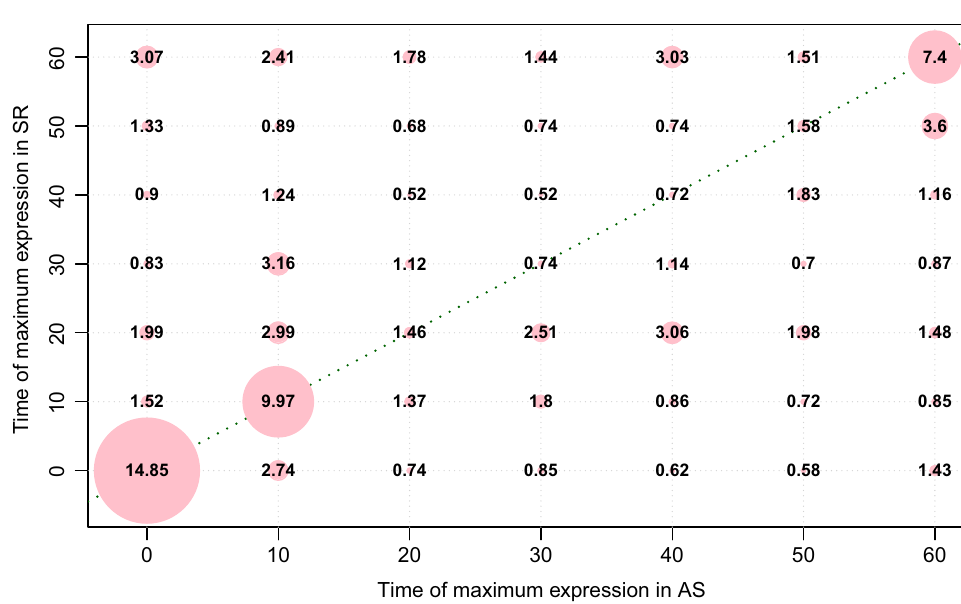
Figure 6. Matrix of percentages of genes peaking at each one of the 49 possible combinations of seven times in accession “AS” ( X -axis) and seven times in accession “SR” ( Y -axis). The percentage of genes simultaneously presenting the peaks is shown at each intersection, while the size of the circles at each intersection corresponds with the proportion of genes. The green dashed line in the diagonal signals the cases where the expression peaks coincide in both